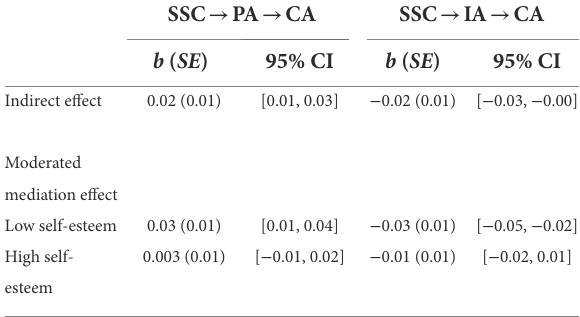
TABLE 2 Results of mediation effect and moderated mediation effect.